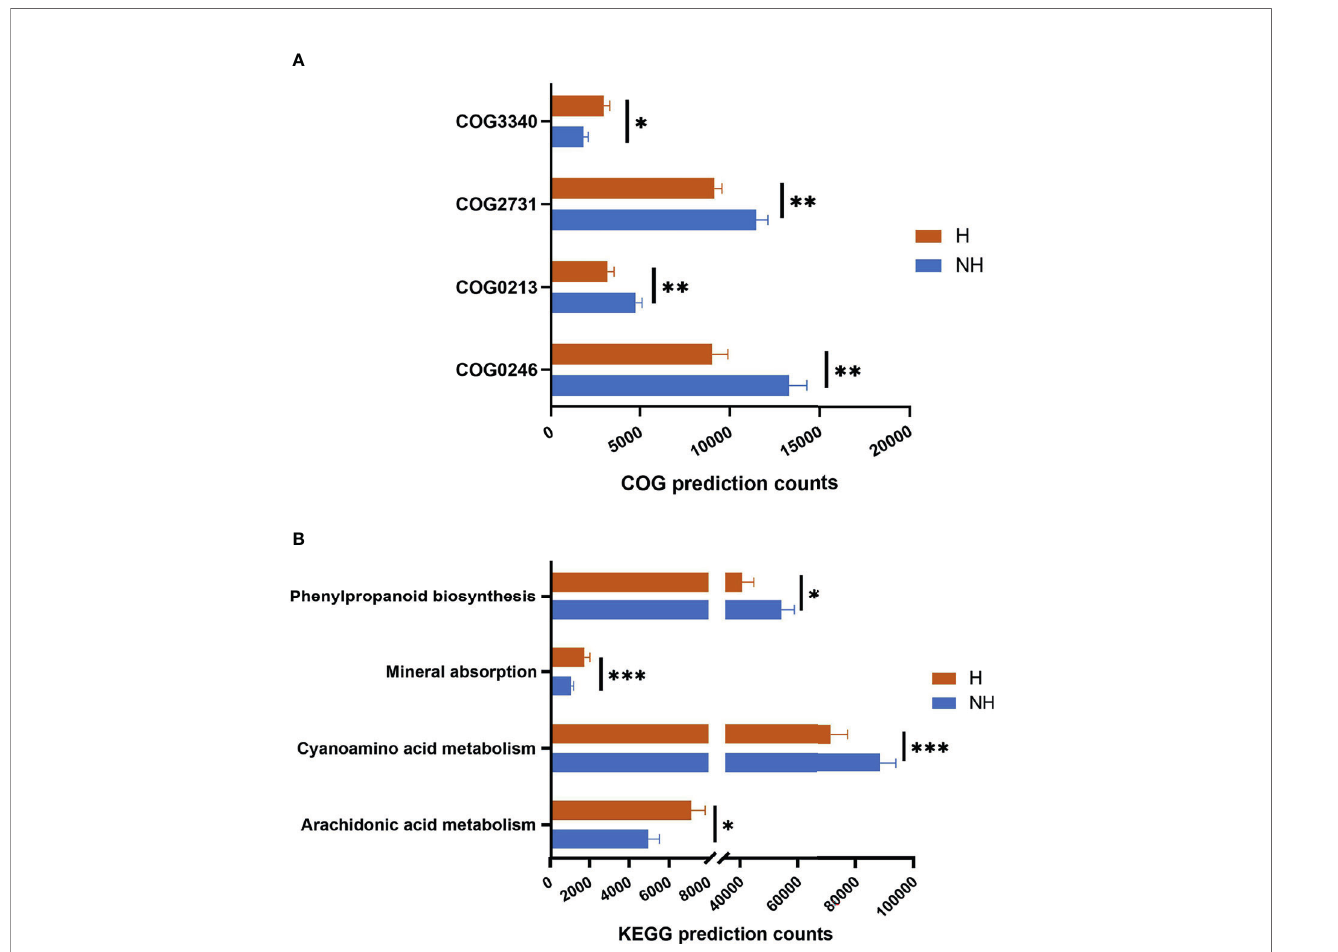
FIGURE 6 | The distribution offunctional categories. The distribution of (A) COG and (B) KEGG function with signi fi cant difference between two groups. The columnlength represents the corresponding samples in this metabolic pathway,and the error bar represents the standard error of abundance. * p < 0.05, ** p < 0.01, *** p <